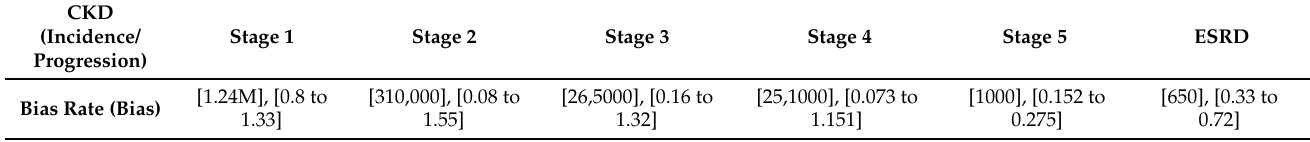
Table 1. The Variation of the CKD Progression with the Bias Involved in Each